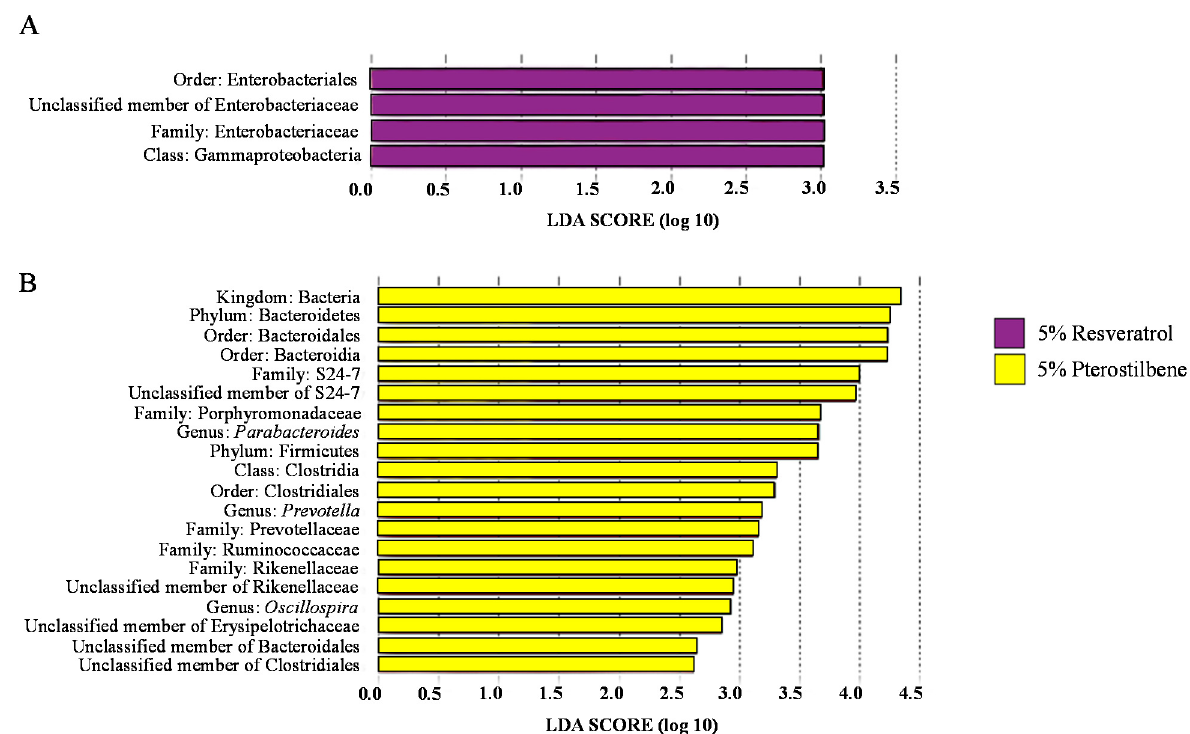
Figure 5. LEfSe analysis identifying the most differentially enriched taxa in the intra-amniotic administration of stilbenes. ( A ) In purple, computed linear discriminant analysis (LDA) scores of the relative abundance difference between the 5% resveratrol group and the no injection control group. ( B ) In yellow, computed LDA scores of the relative abundance difference between the 5% pterostilbene group and the no injection control